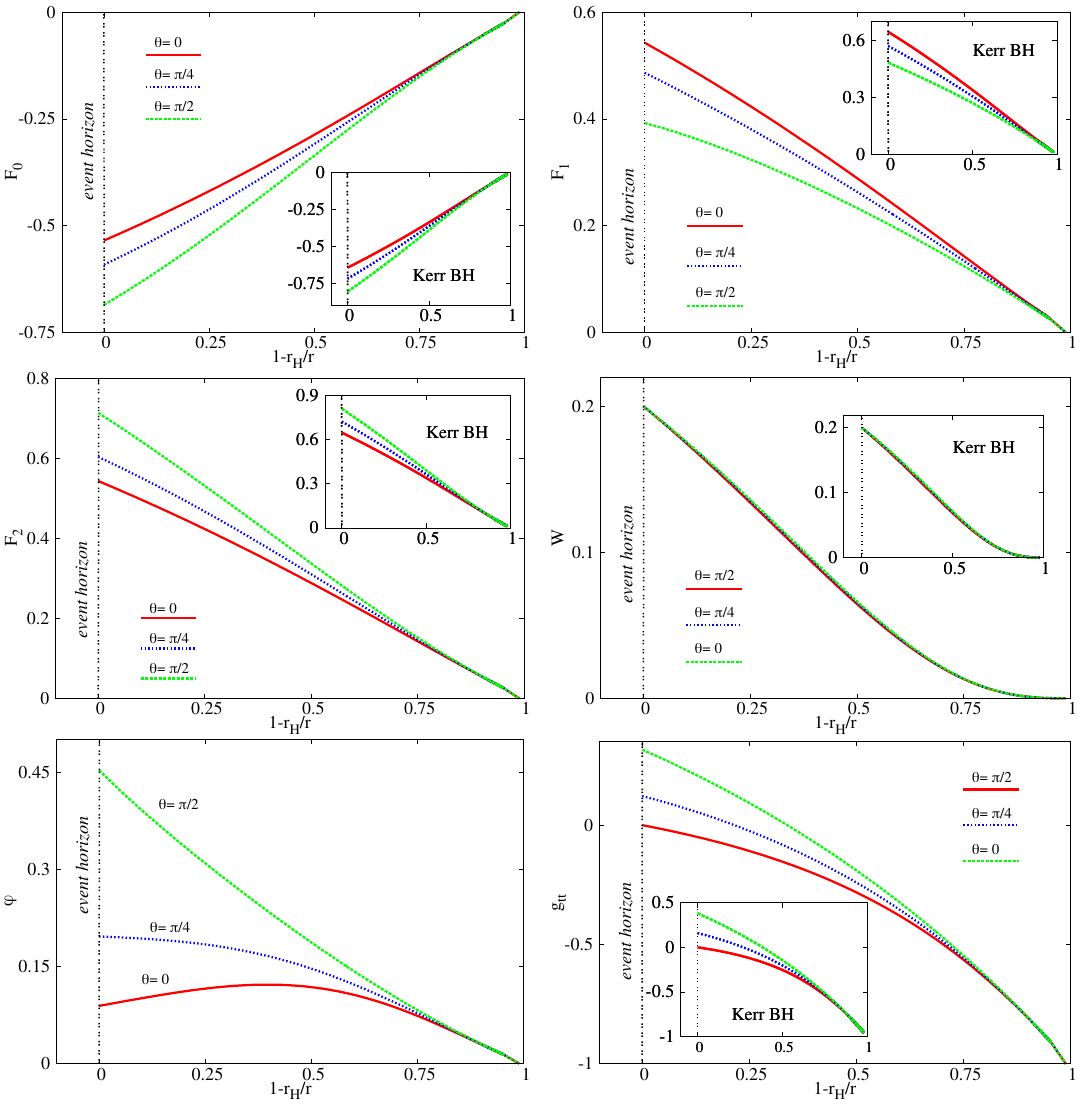
Figure 1 . Pro(cid:12)le functions of a typical solution with r H = 1 : 38, (cid:10) H = 0 : 2, (cid:11) = 0 : 4, vs. 1 (cid:0) r H =r , which compacti(cid:12)es the exterior region, for three di(cid:11)erent polar angles (cid:18) . The insets show the corresponding functions for a Kerr BH with the same r H ; (cid:10) H . The behaviour is qualitatively similar for both cases, with small quantitative